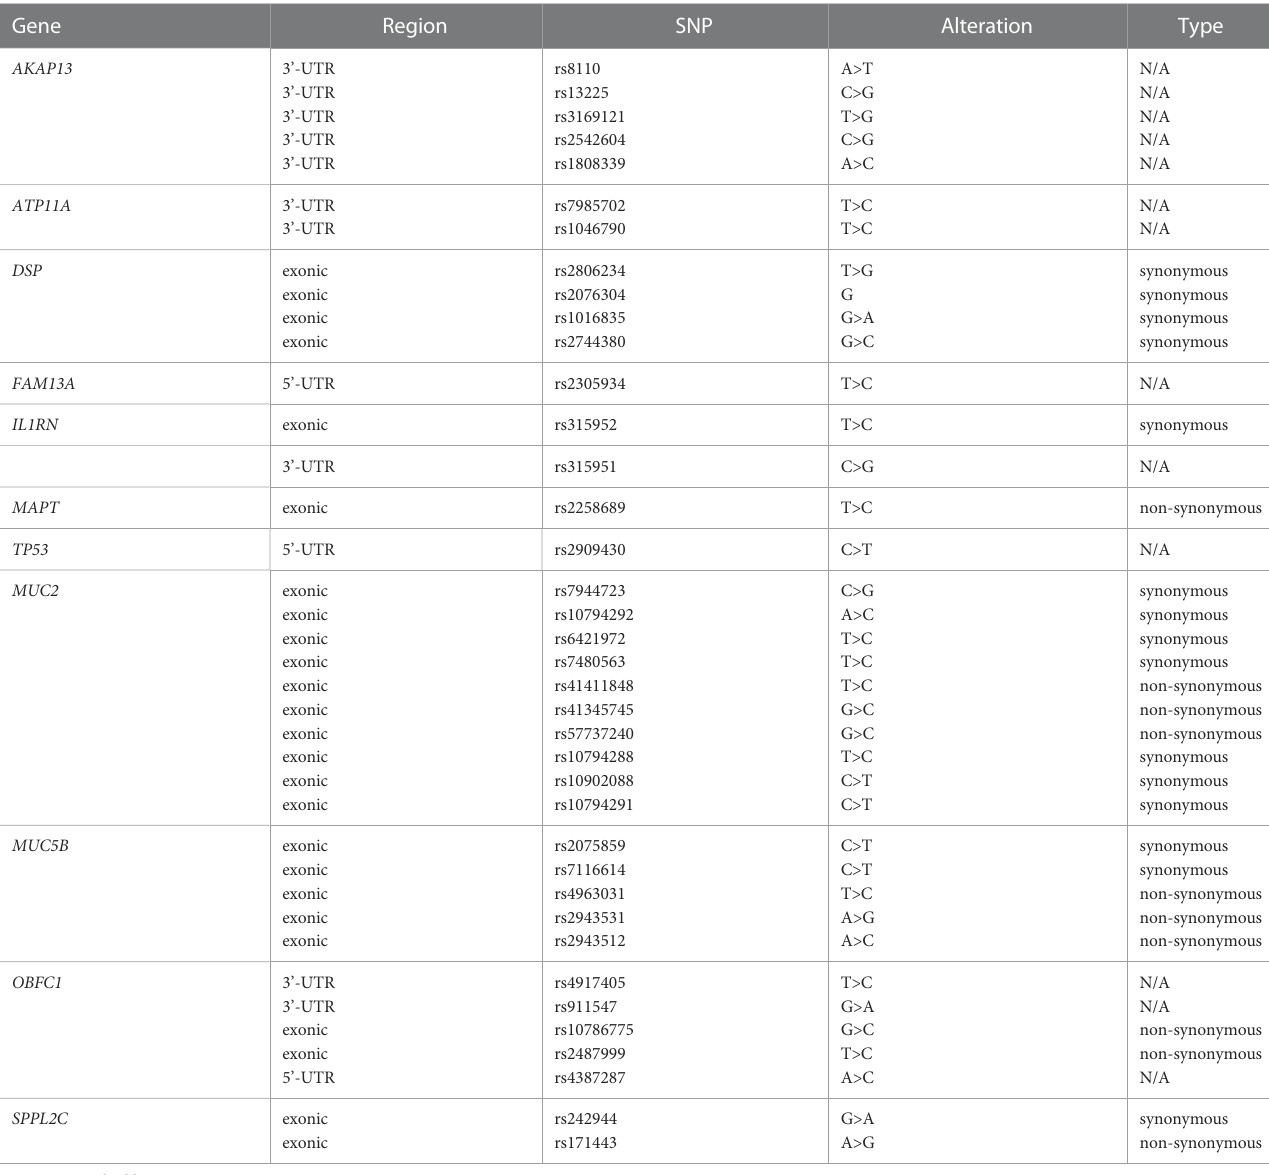
TABLE 5 The common SNPs within the genes associated with IPF. Gene Region SNP Alteration